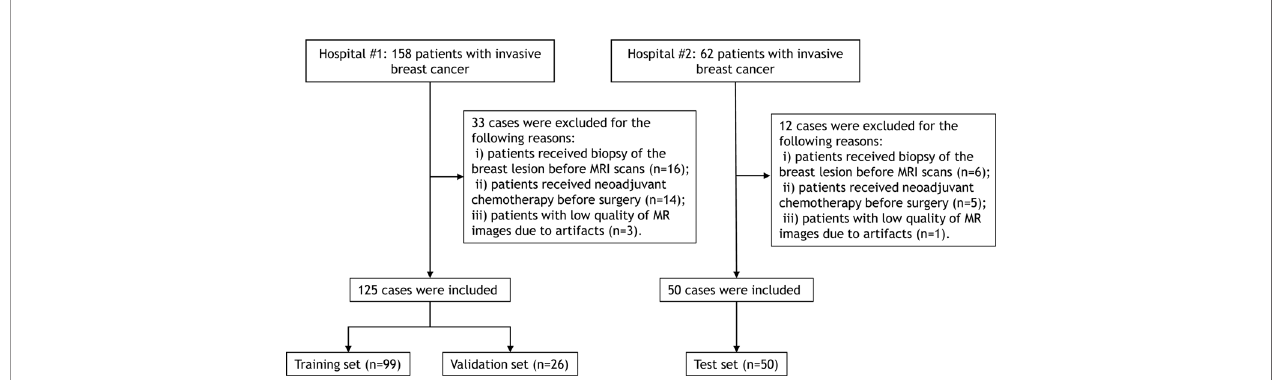
FIGURE 1 | Flowchart for selection of the study